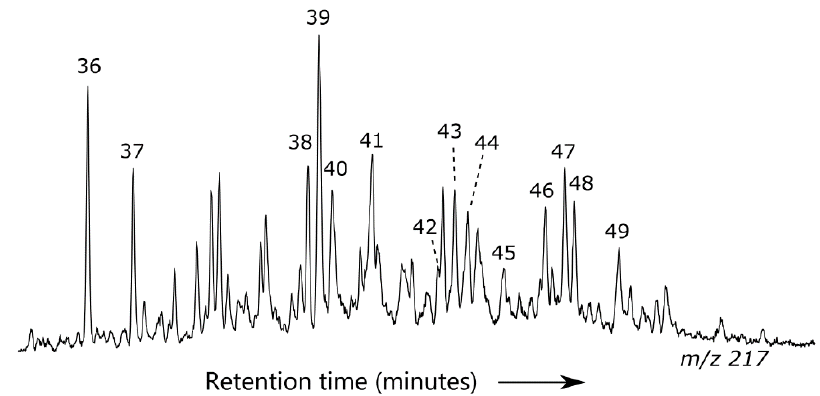
Figure 5. Example of m / z 217 ion chromatogram showing sterane distribution for a representative oil sample.